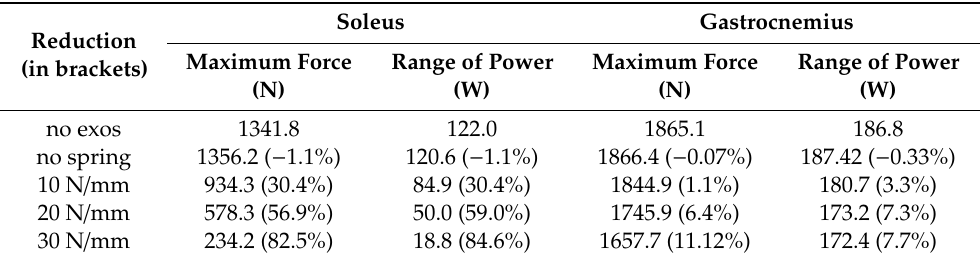
Table 2. Comparison of forces and power of plantar flexor muscles.